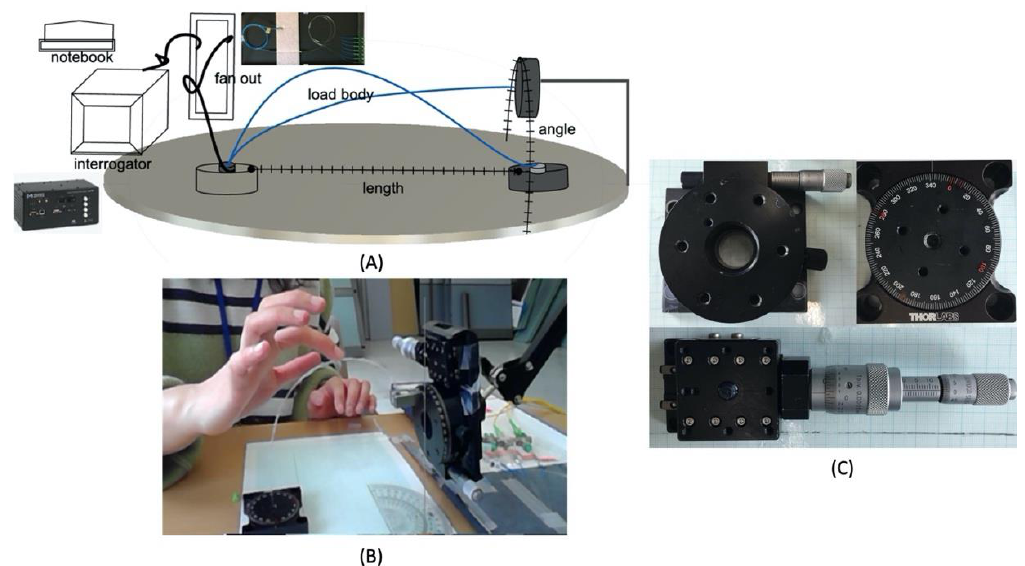
Figure 5. The measurement equipment used in the experiment. ( A ) Structure of experimental measurement. ( B ) Actual photo of experimental measurement. ( C ) Manual measuring tool. The